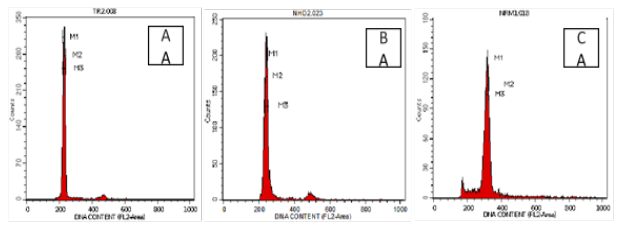
Figure 1: Histograms of nuclei fluorescence intensity: (A) C. sativus (B) C. melo inodorus, (C) C. melo centalupensis